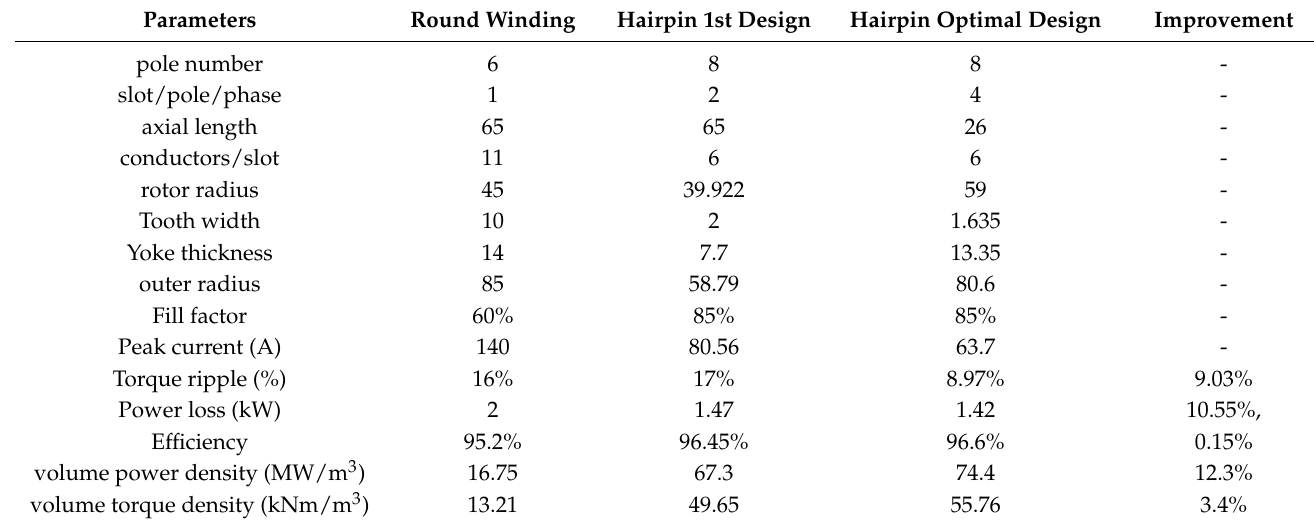
Figure 10. Comparison between the geometries of ( a ) the first analyzed motor and ( b ) the optimal motor. Table 4. Summarizing comparison among the benchmark motor [17], the hairpin motor obtained through the first sensitivity analysis and the optimum hairpin